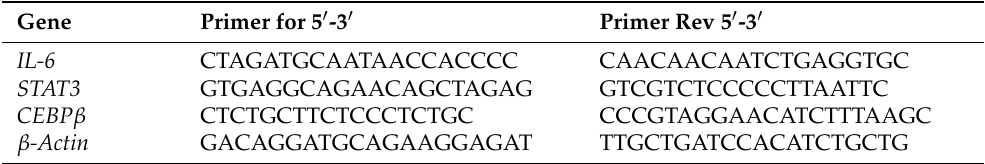
Table 1. List of genes and sequences of primers used for qPCR